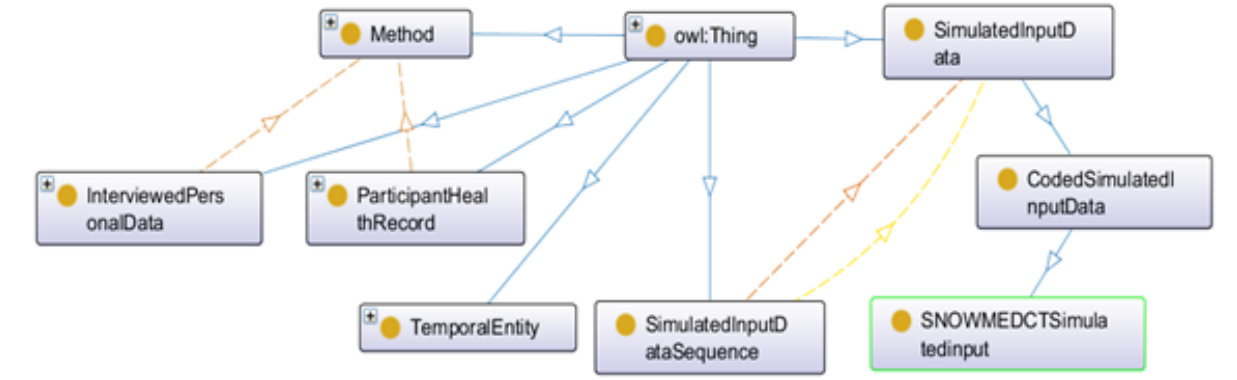
Figure 15. Ontology for data collection from simulated